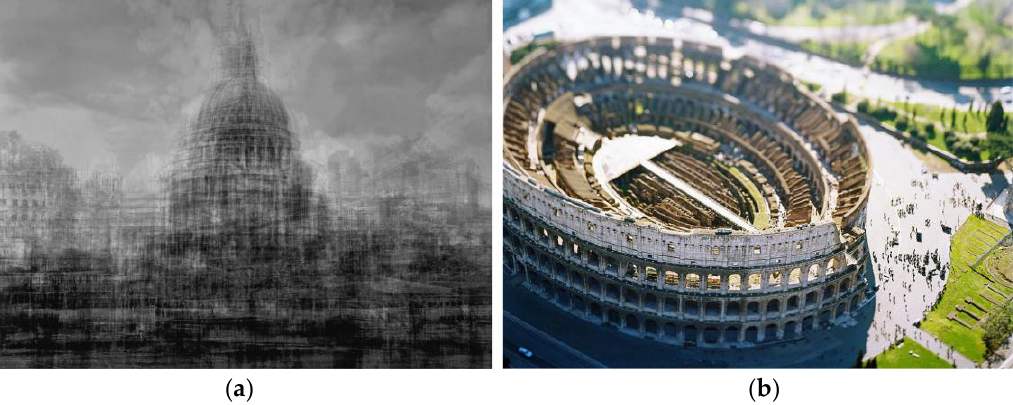
Figure 5. ( a ) Idris Khan, St. Paul's Cathedral , London, 2012; ( b ) Olivo Barbieri, Colosseo , Roma,